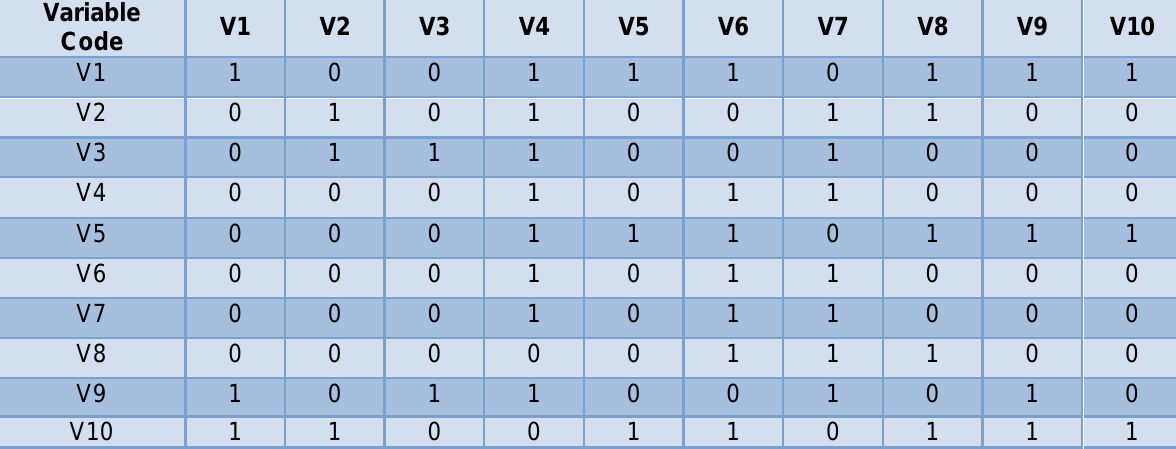
Table 3 Reachability matrix Partitioning the Reachability Matrix Into Different